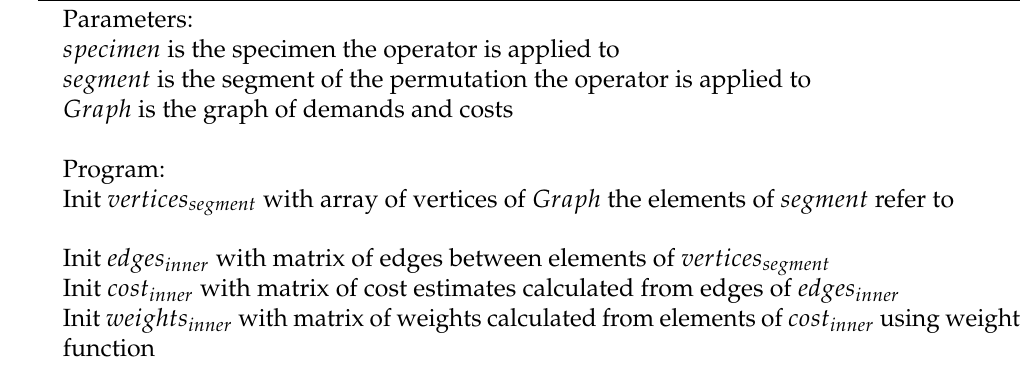
Algorithm 6 Mutation operator with edge builder